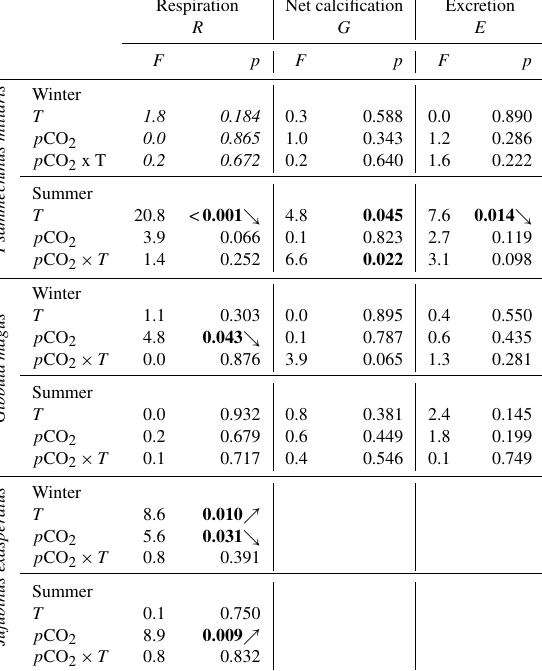
Table 4. Results the analysis of variance testing the effects of temperature ( T ) and p CO 2 on respiration, net calcification, and excretion rates in the urchin Psammechinus miliaris and the two gastropods Gibbula magus and Jujubinus exasperatus for winter and summer experiments ( n = 5). Statistical analyses were per- formed using two-way crossed ANOVAs and Scheirer–Ray–Hare tests when test assumptions were not respected (in italic). Signifi- cant p values are shown in bold ( α = 0.05). Degrees of freedom = 1. Respiration Net calcification Excretion R